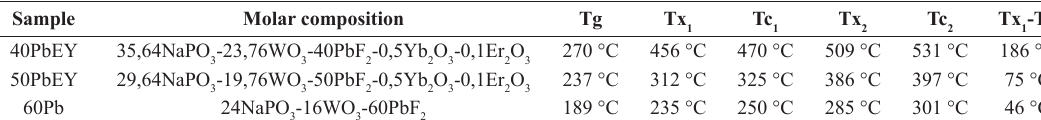
Table 1. Molar compositions and characteristic temperatures of glass samples.